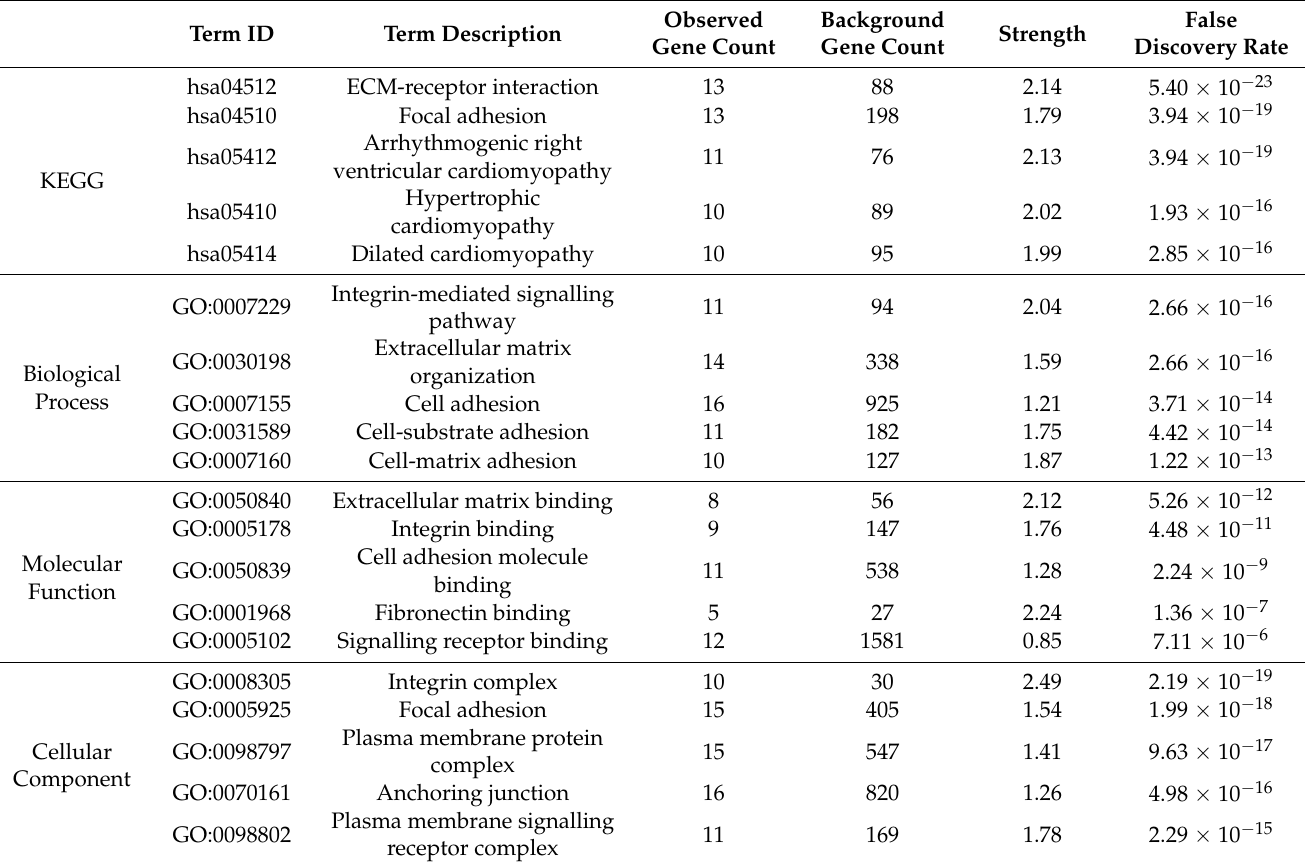
Table 1. Kyoto Encyclopedia of Genes and Genomes (KEGG) enrichment and GO analysis of neighbouring genes for